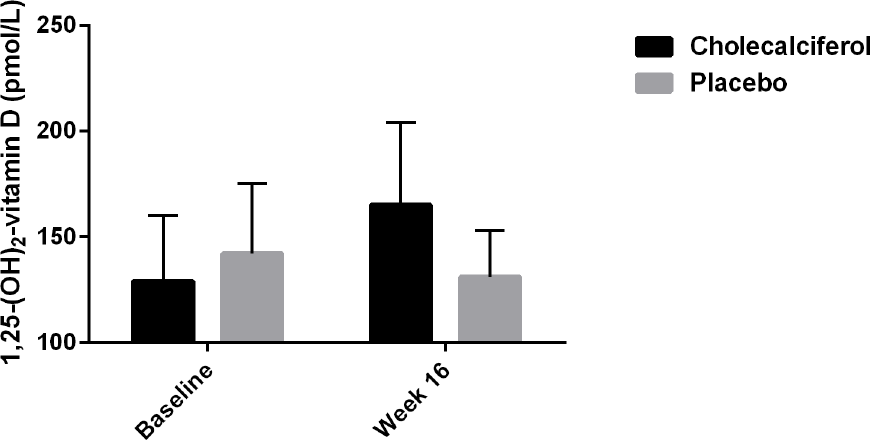
Fig 2. Treatment Effect on 1,25-(OH) 2 Vitamin D